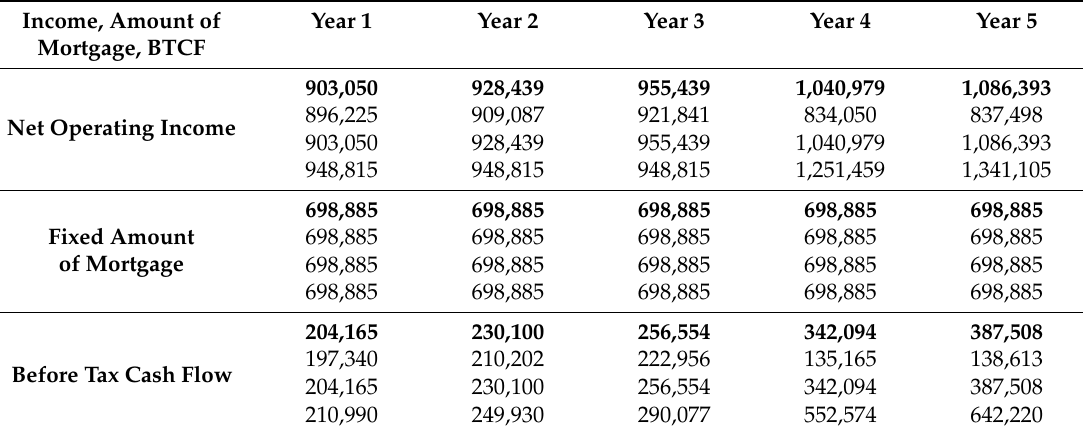
Table 8. Calculation of Before Tax Cash